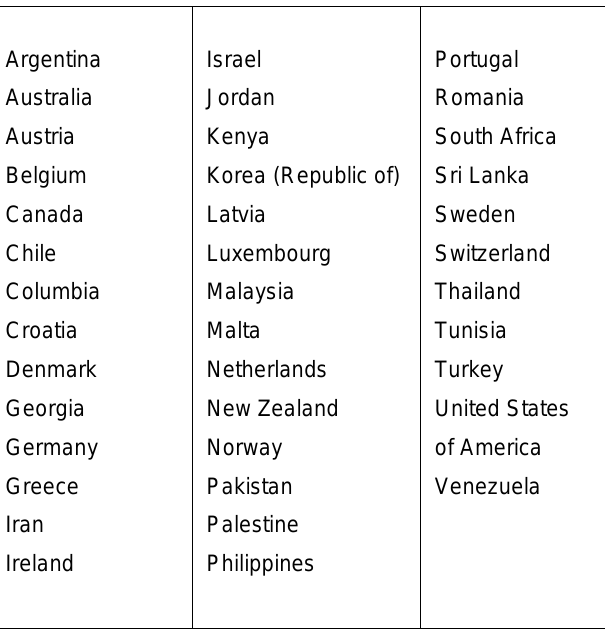
Table 1. Countries Represented in the WFOT Telehealth